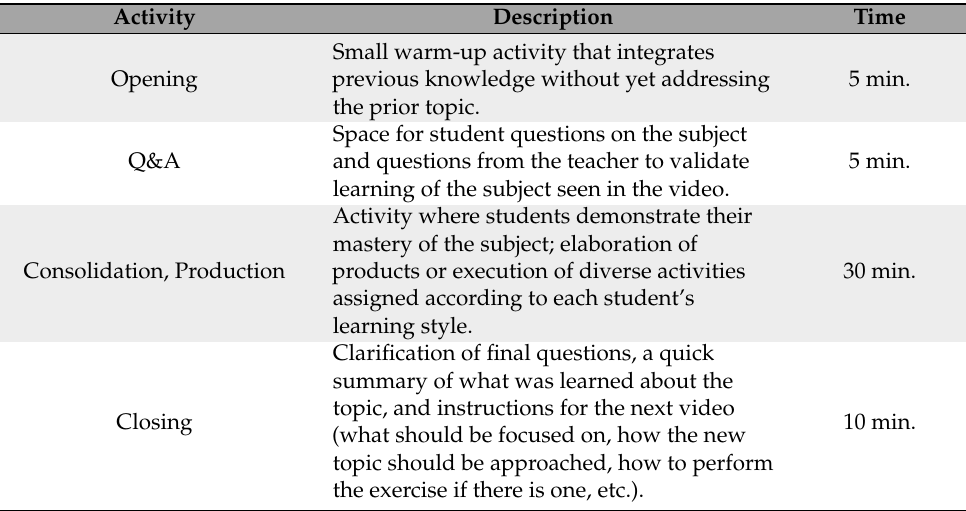
Table 3. The format used for the design of classes with the Flipped Classroom model. Activity Description Time Small warm-up activity that integrates Opening previous knowledge without yet addressing Space for student questions on the subject and questions from the teacher to validate learning of the subject seen in the